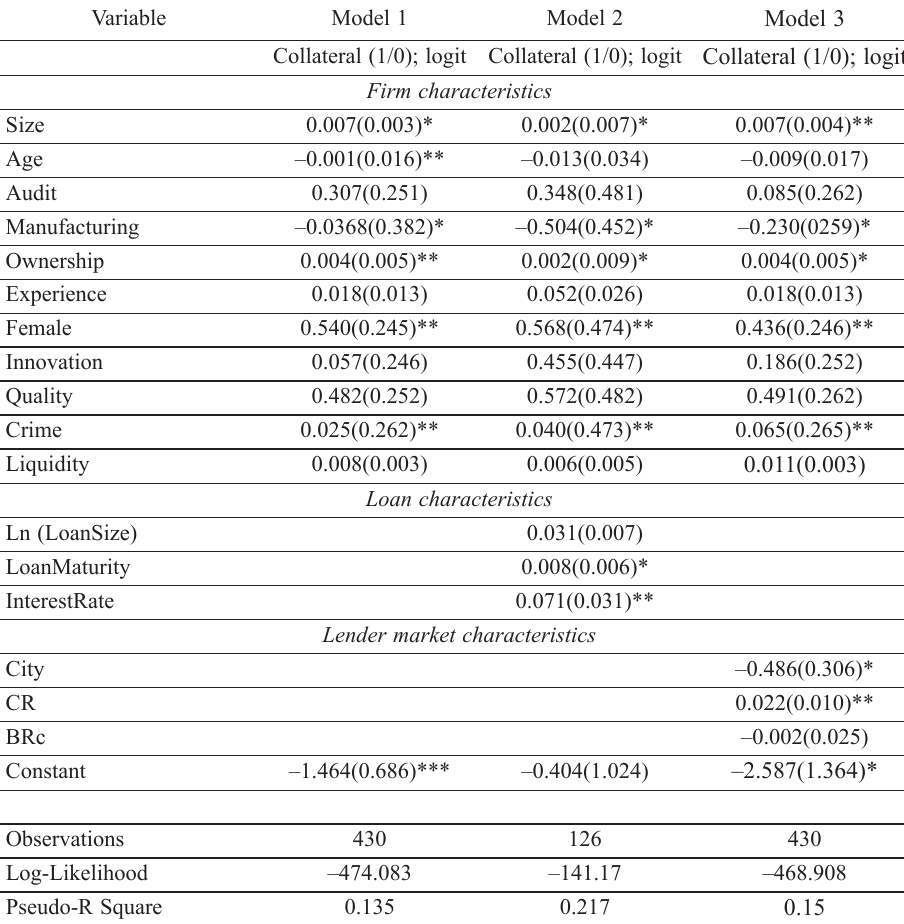
Table 4. Logistic regression on the presence of